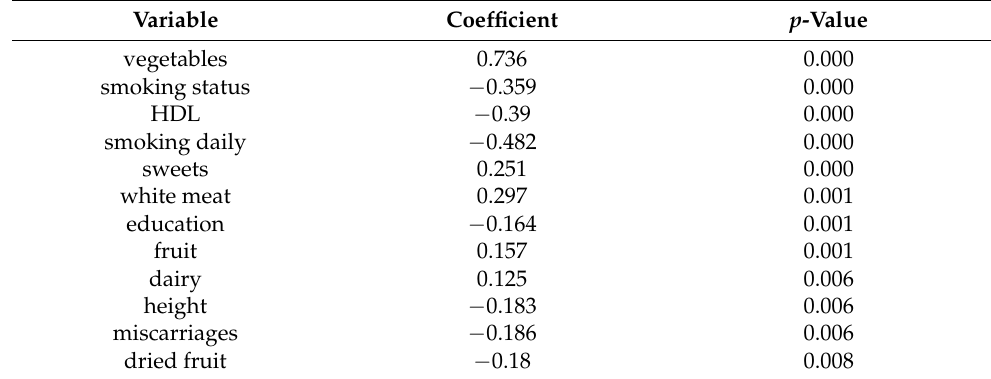
Figure 2. ( a ) PCA scores of the nutrition variables (Appendix A). The scores are colored based on the cohort (blue = NIH, red = CRIBS); ( b ) A bar plot of the PCA loadings. Table 2. Coefficients of variables used in PCA. The PCA plots are given in Figure 2.